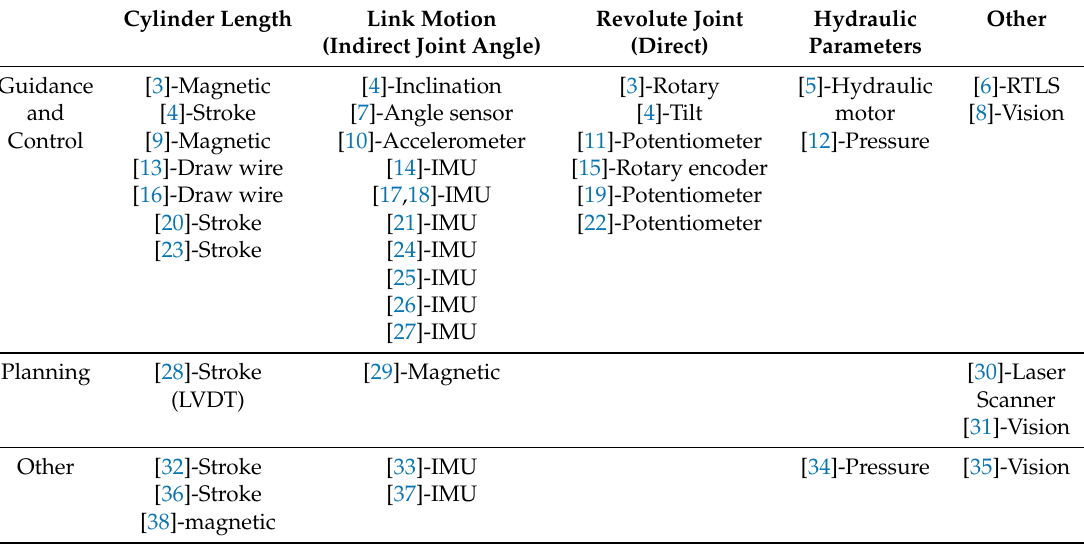
Table 1. Recent studies about sensors application in the